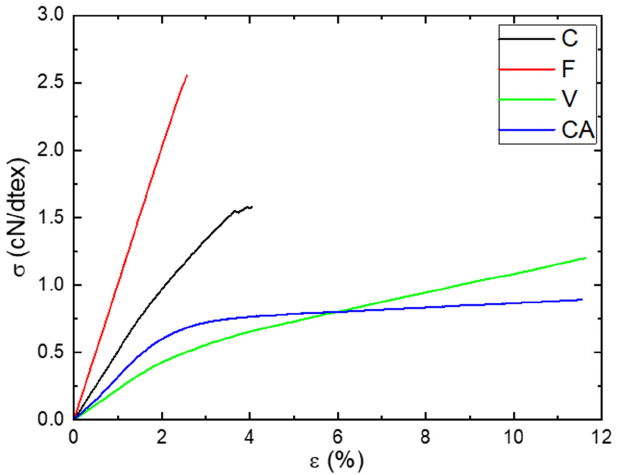
Figure 9. Evolution of the stress as a function the strain at a w = 0.47 and T = 25 °C for C, F, V and CA fibers. Table 4. Values of tensile module ( E ), stress at break ( σ ) and strain at break ( ε ) for a w = 0.47.